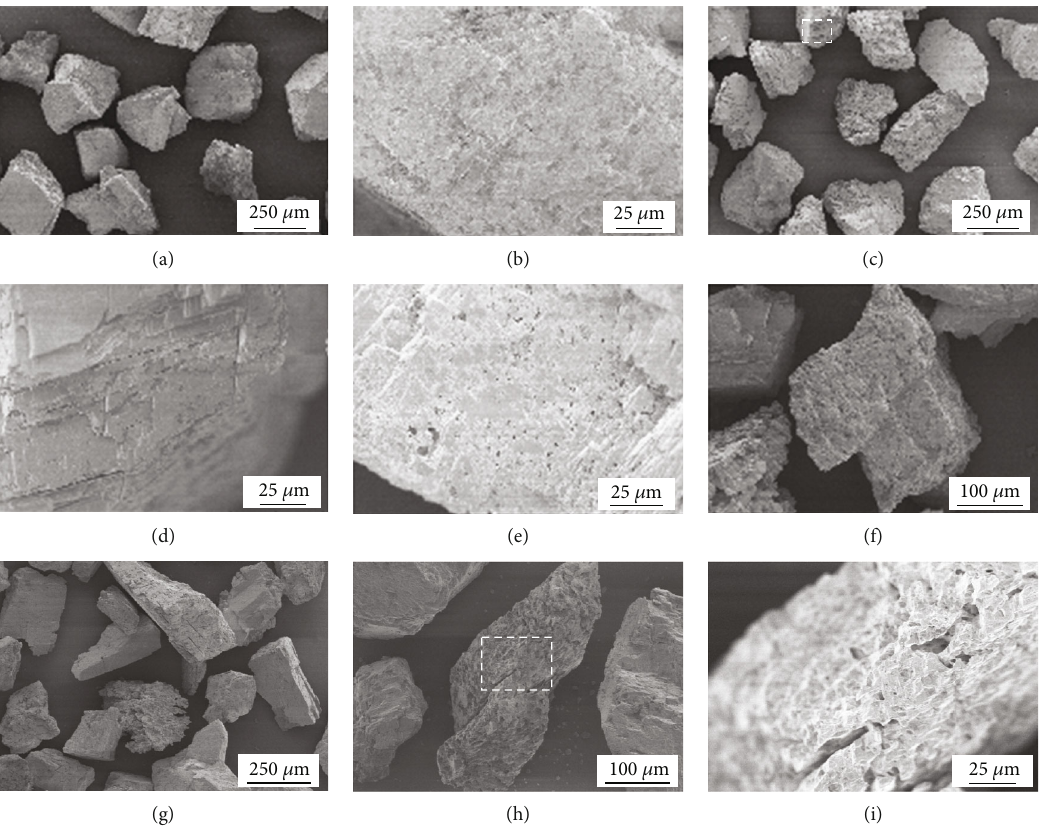
Figure 5: SEM images of initial and altered rock grains in the dolostone series. (a) Grains with smooth, fl at surfaces in initial dolostone; (b) smooth surface of an uncorroded grain with no pore development in initial dolostone; (c) corroded grains at 50 ° C; (d) enlarged image of dotted box in 5c showing etched fi ssures along the cleavage; (e) etched pits at 75 ° C; (f – h) etched grains with honeycomb-like pores at 100, 150, and 200 ° C, respectively; (i) enlarged image of dotted box in 5h showing honeycomb-like pores at 200 °